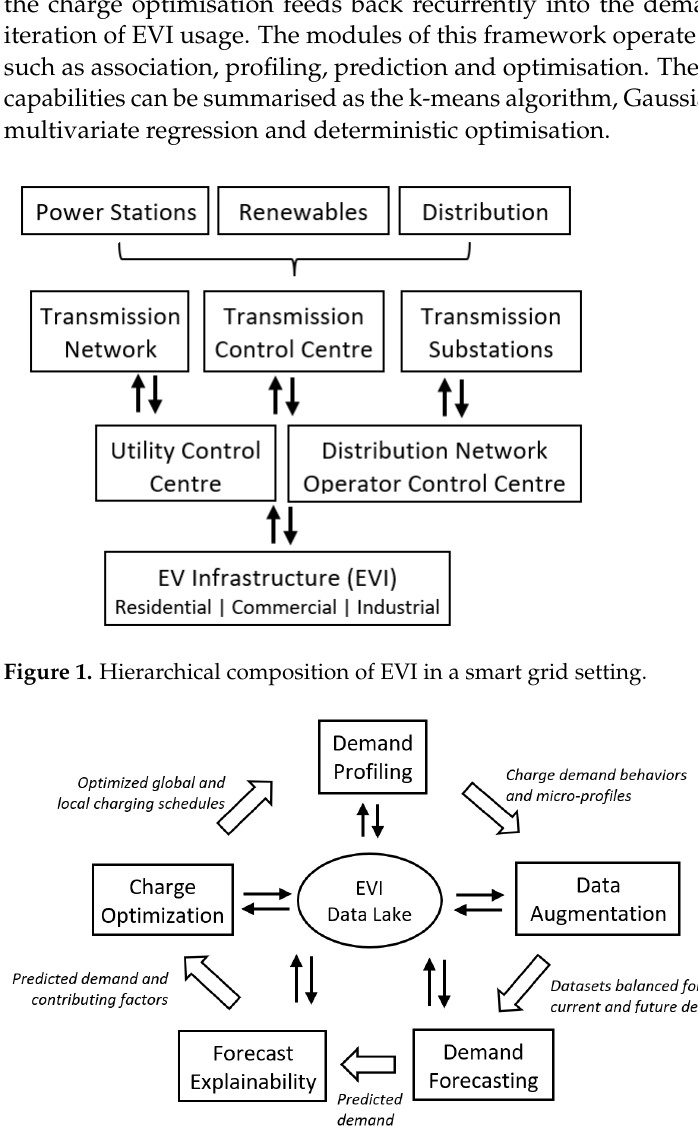
Figure 2. Proposed AI framework for electric vehicle infrastructure